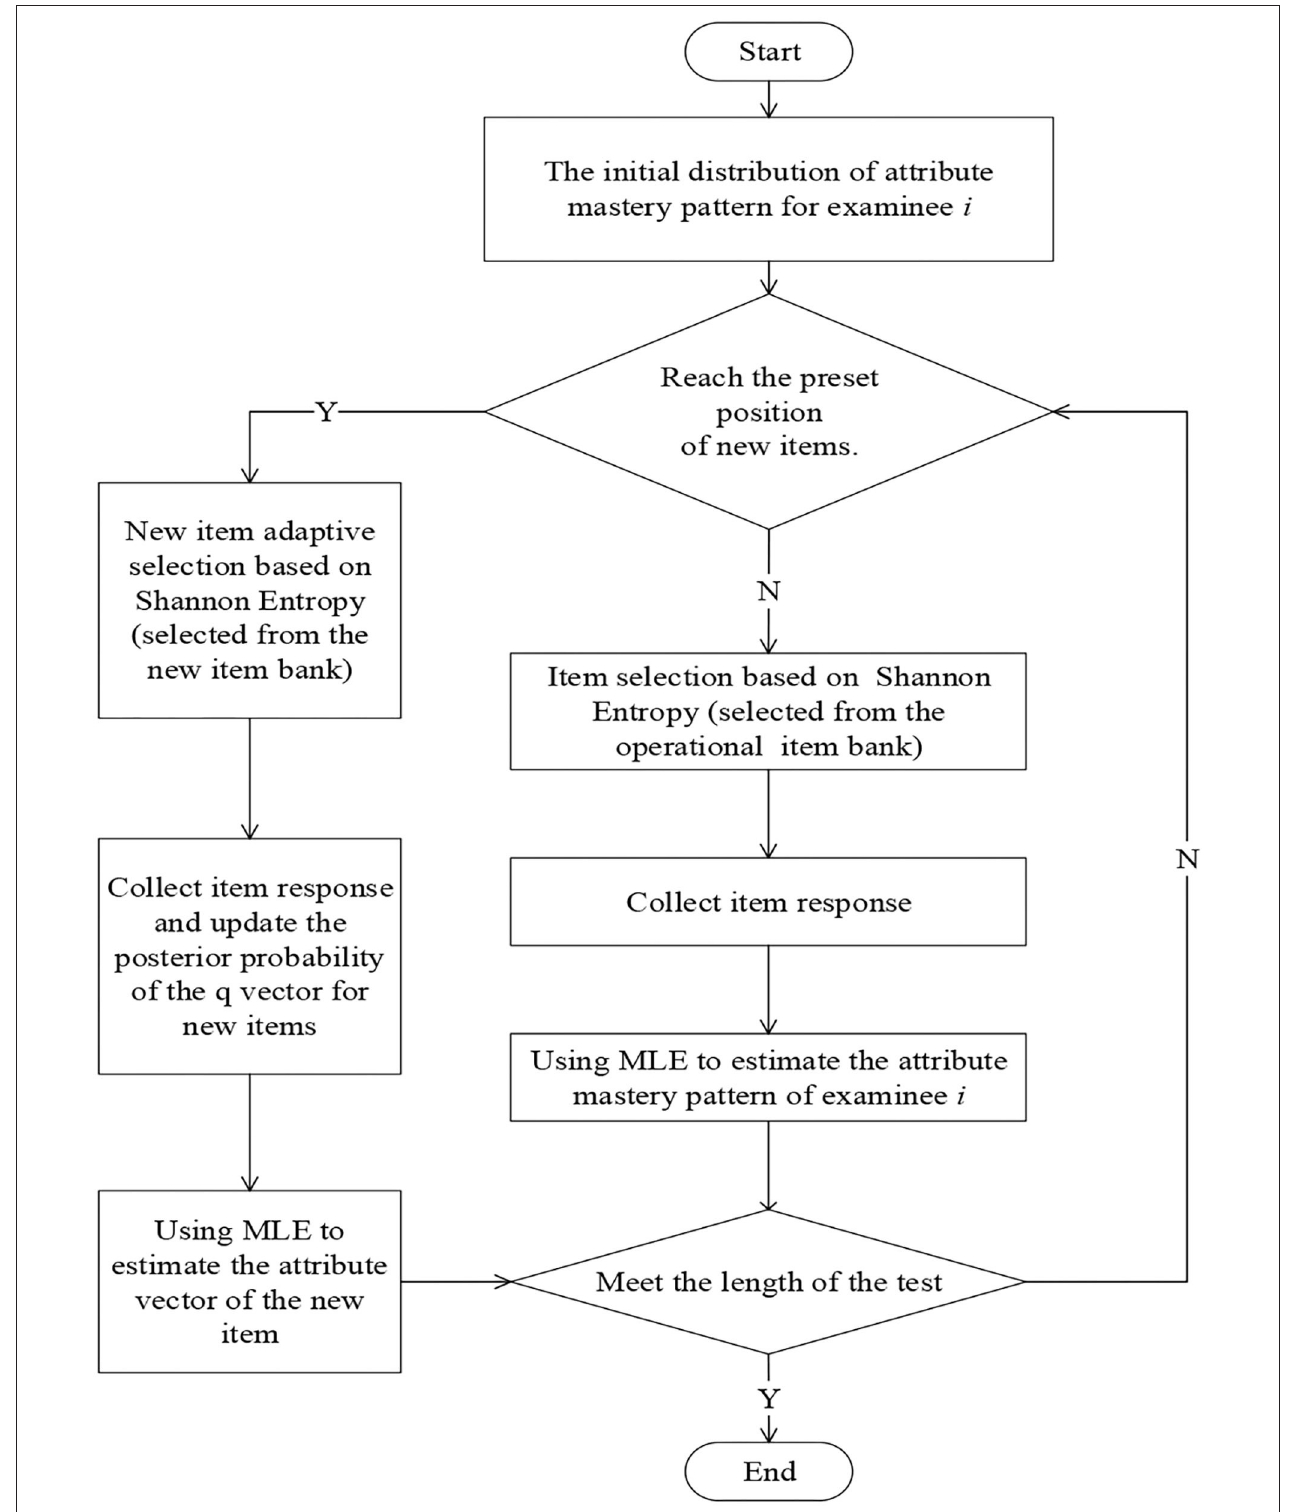
FIGURE 1 | The flow chart of the calibration of item attribute vector based on Shannon entropy.